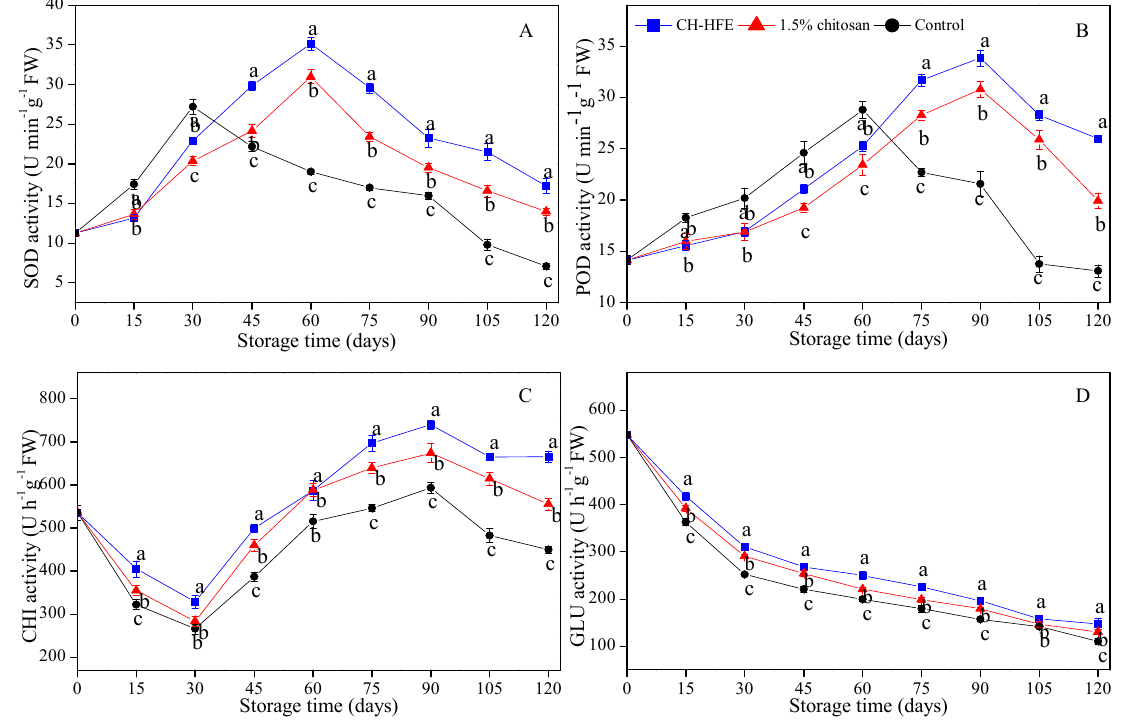
Figure 5. Changes in the activities of SOD ( A ), POD ( B ), CHI ( C ), and GLU ( D ) of navel orange fruits stored at 5 °C for 120 days. Each value represents the mean ± SE of three replicates selected randomly from 30 fruits each